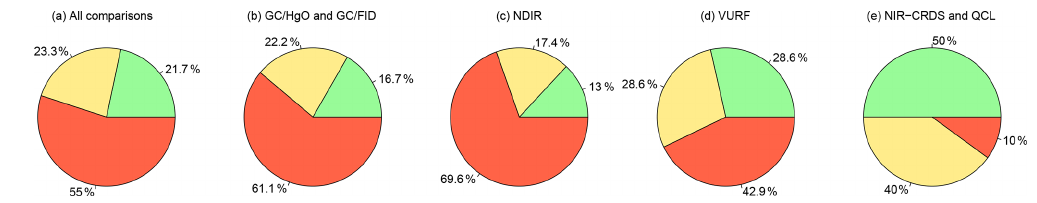
Figure 2. Percentage of CO performance audit results that were in the range of 30–300nmolmol − 1 within the WMO/GAW network com- patibility goals (green), the extended network compatibility goals (yellow), or outside the network compatibility goals (red area) for (a) all comparisons, (b) GC systems, (c) NDIR analysers, (d) VURF analysers, and (e) NIR-CRDS and QCL systems.